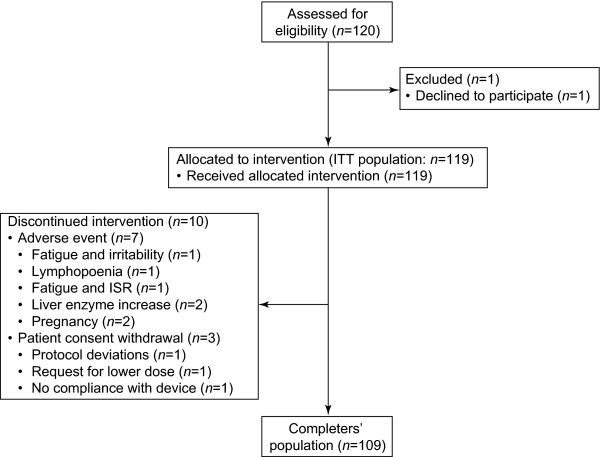
Patient disposition. ISR, injection-site reaction; ITT, intent-to-treat.